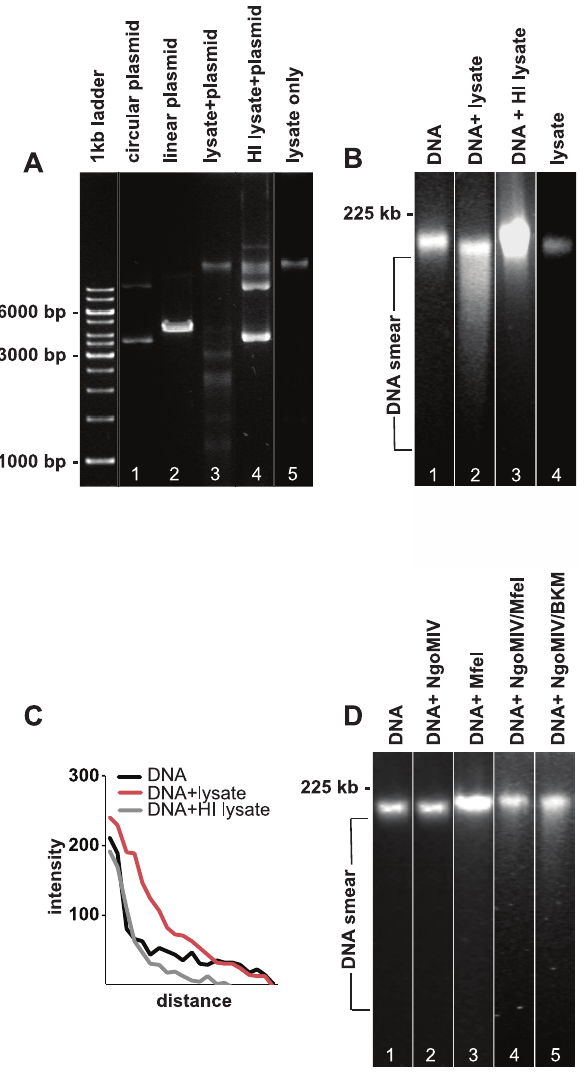
Figure 2. Lysates of N. gonorrhoeae fragments pECFP-N1 and damage DNA from VK2/E6E7 cells. A. DNA agarose gel showing the digestion of pECFP-N1 plasmid by HindIII (positive control, lane 2), MS11 P + lysate (lane 3), and MS11 P + HI lysate (lane 5). Lane 5 shows bacterial MS11 P + lysate without pECFP-N1 and lane 1 shows uncut circular pECFP-N1. B. PFGE analysis of purified VK2/E6E7 genomic DNA treated for 24 h with: lane 1: PBS (negative control), lane 2: MS11 P + lysate, lane 3: MS11 P + HI lysate. Lane 4 shows bacterial MS11 P + lysate without VK2/E6E7 genomic DNA. C. Graph showing quantification of DNA smears (measured directly underneath and below the band). Shown are smear pixel intensities of cellular DNA alone and cellular DNA exposed to bacterial lysates and HI bacterial lysates. D. PFGE showing genomic DNA subjected to commercial restriction enzymes for 24 h. Lane 1: DNA incubated with CutSmart reaction buffer (negative control). Lane 2: DNA incubated with NgoMIV. Lane 3: DNA incubated with MfeI, Lane 4: DNA incubated with NgoMIV and MfeI Lane 5: DNA incubated with NgoMIV and BamHI/KpnI/MfeI (BKM).